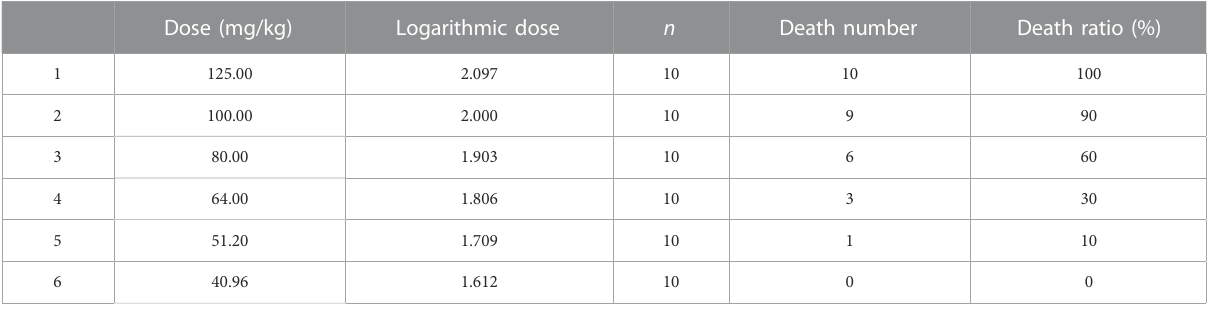
Figure S1B) of T2DM mice. The blood glucose of the mice was also monitored during the observation period. After continuous treatment with HFD/STZ, the FBG of T2DM mice increased sharply in the fi rst week and then decreased gradually from 2 weeks to 4 weeks. Importantly, like Met, HAS treatment decreased FBG in T2DM mice at all observation time points (Figure 1C). In fact, after 1 week of treatment with a high dose of HAS, the FBG of the T2DM mice decreased signi fi cantly ( p ≤ 0.01 vs. HFD + STZ, Supplementary Figure S1C). At week 3, 2.5 mg/kg HAS treatment also signi fi cantly reduced FBG in T2DM mice (Supplementary Figure S1C). At week 4, all HAS- compared with the HFD + STZ group (Figure 1D).